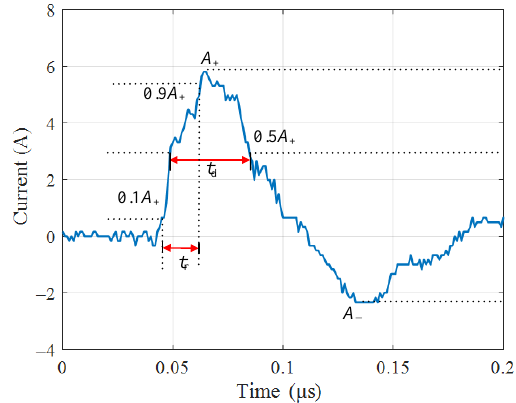
Figure 3. Current waveform of a single arcing discharge.